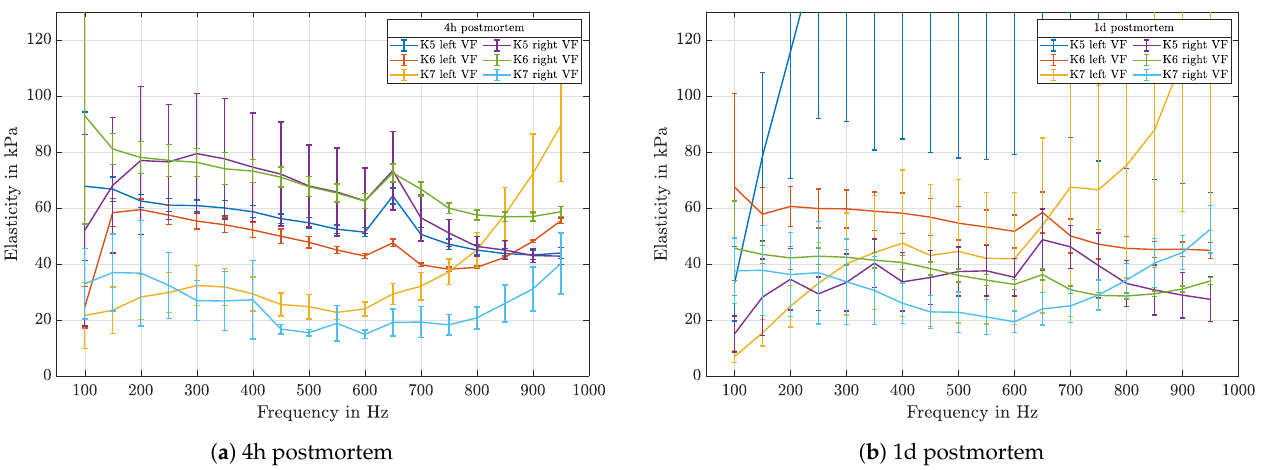
Figure 12. The elasticity values are plotted for each frequency. The measurements were taken 4h and 1 d postmortem and are shown in subfigure ( a ) respectively ( b ). For the left VF on sample K5 the measured values rise up to 180kPa, for an intuitive comparison the axis is kept the